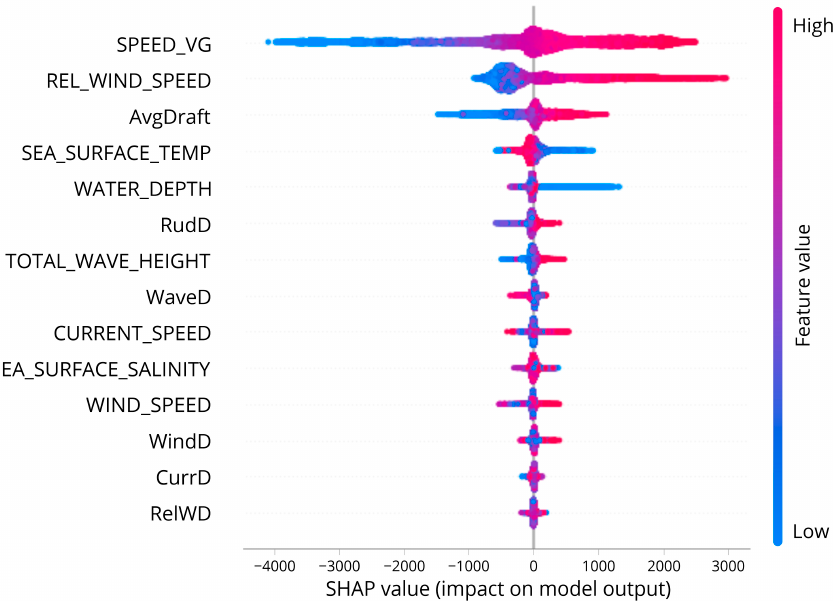
Figure 7. SHAP summary plot.